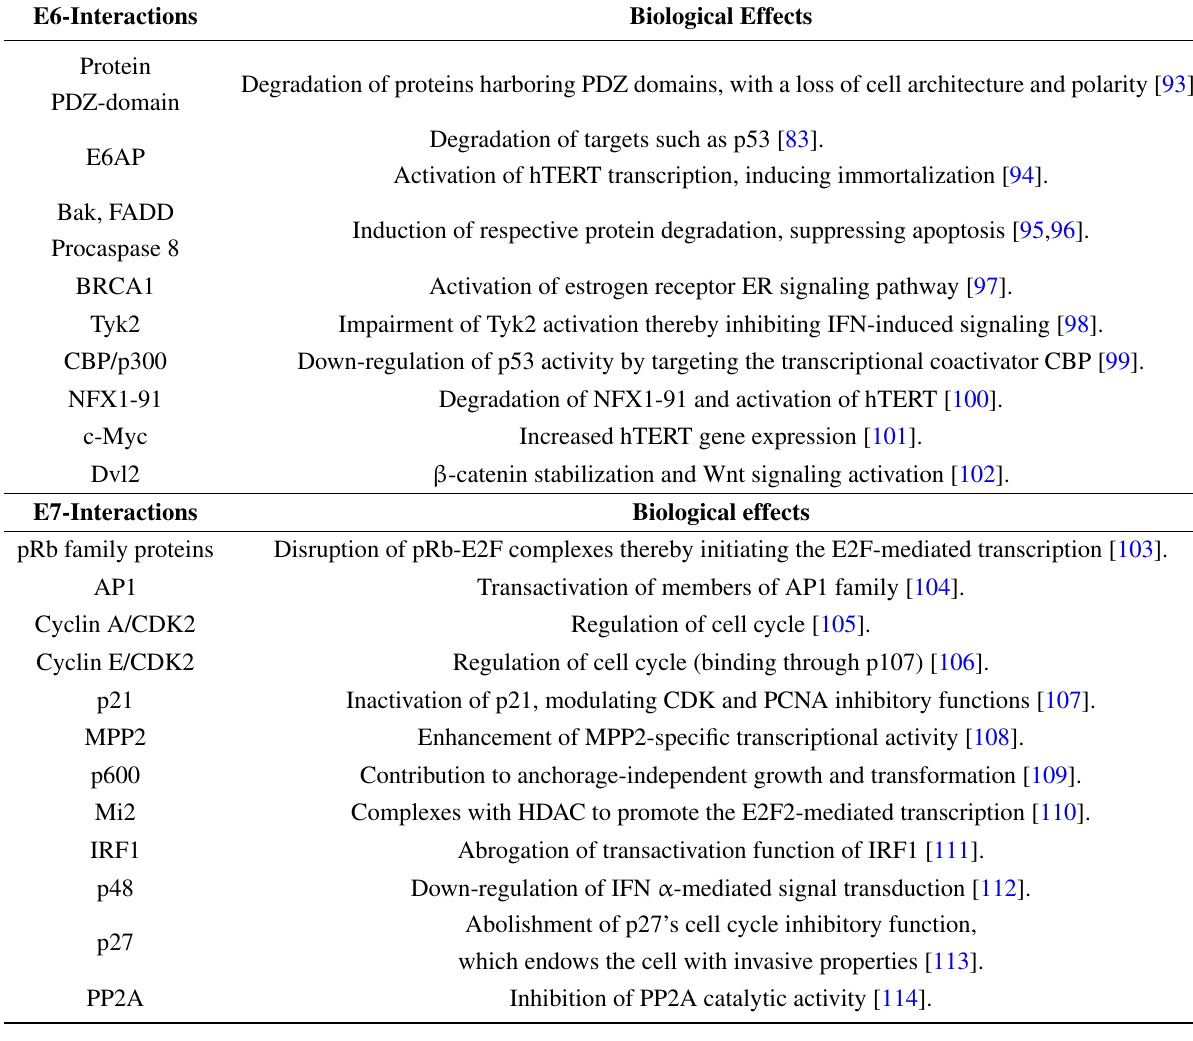
Table 1. Cell biological effects induced by HPV E6 and E7 oncoproteins via interactions with cellular